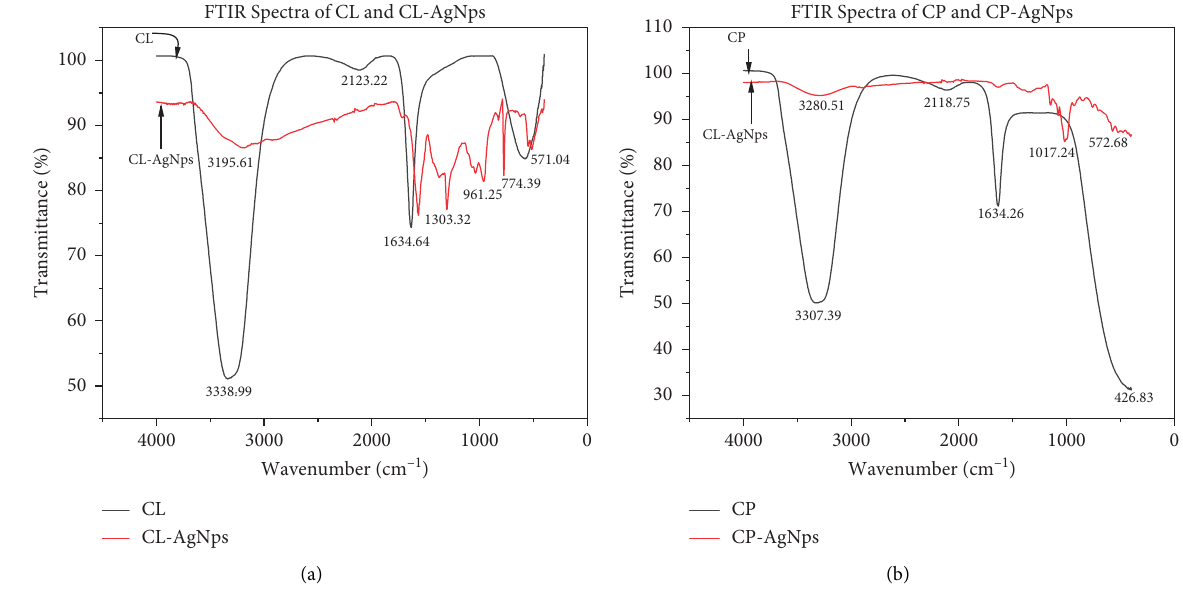
Figure 3: (a) FTIR spectra of Cl and CL-AgNPs. (b) FTIR spectra of CP and CP-AgNPs.